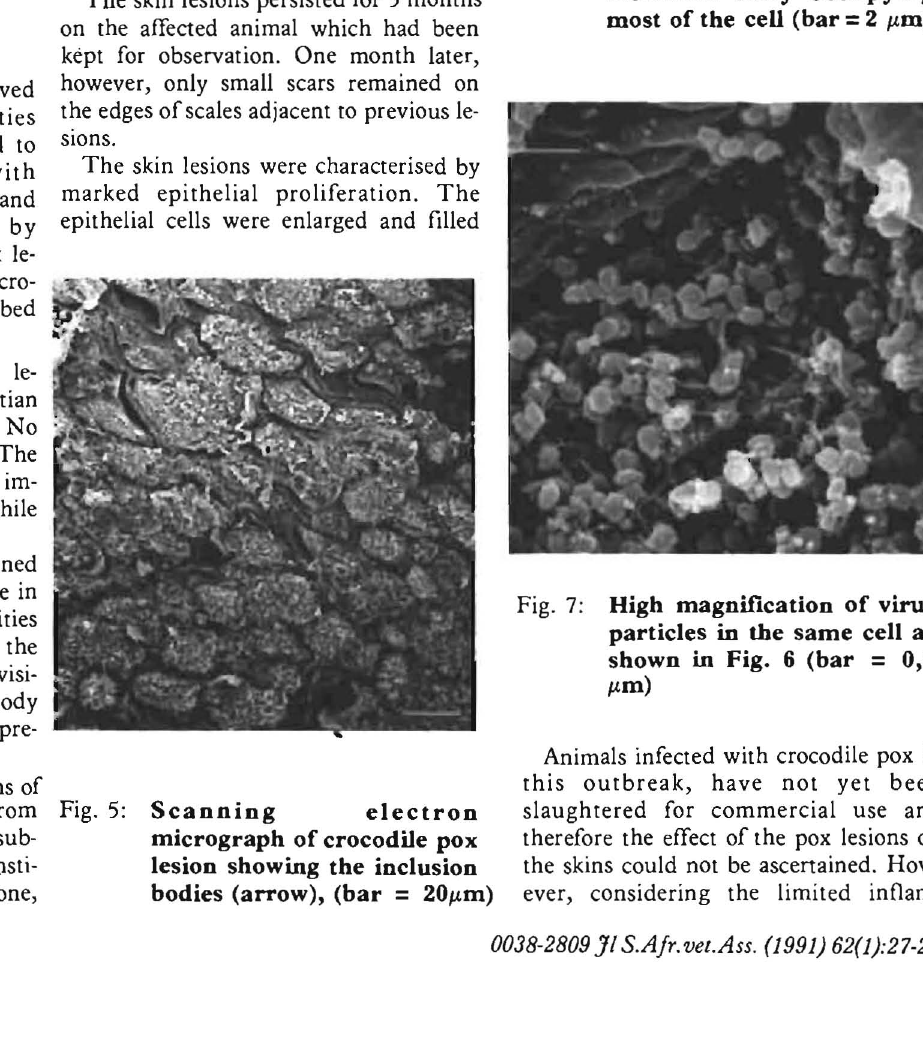
Fig. 6: Scanning electron micro graph of a single epithelial cell revealing densely pack